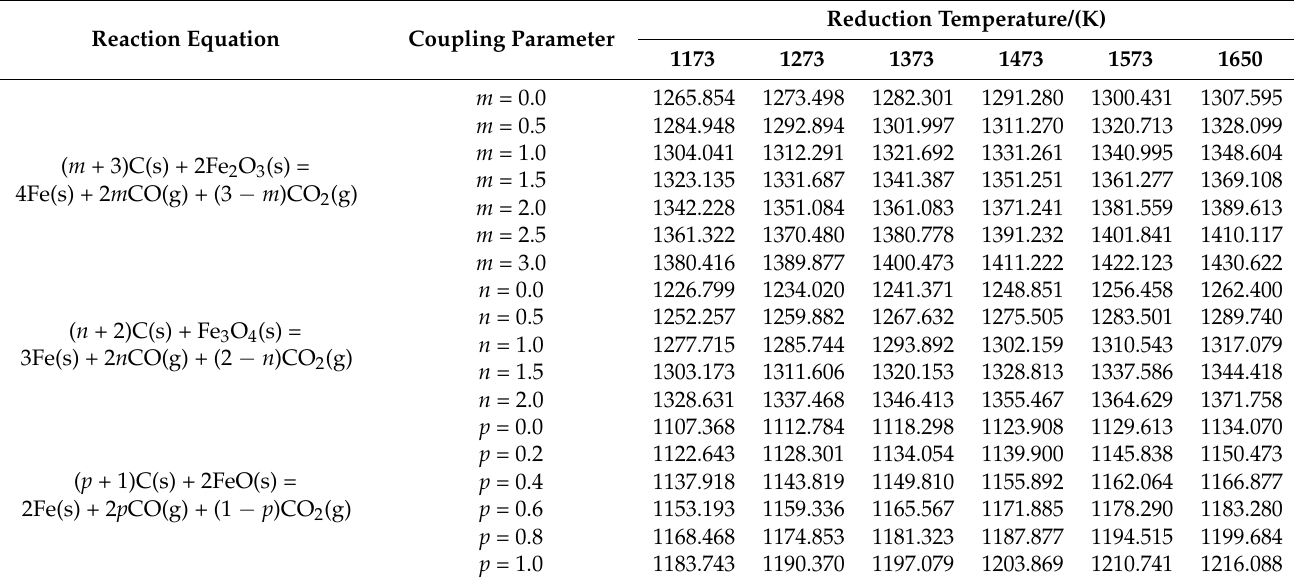
Table 10. The CO 2 output per ton of liquid iron (kg/t).